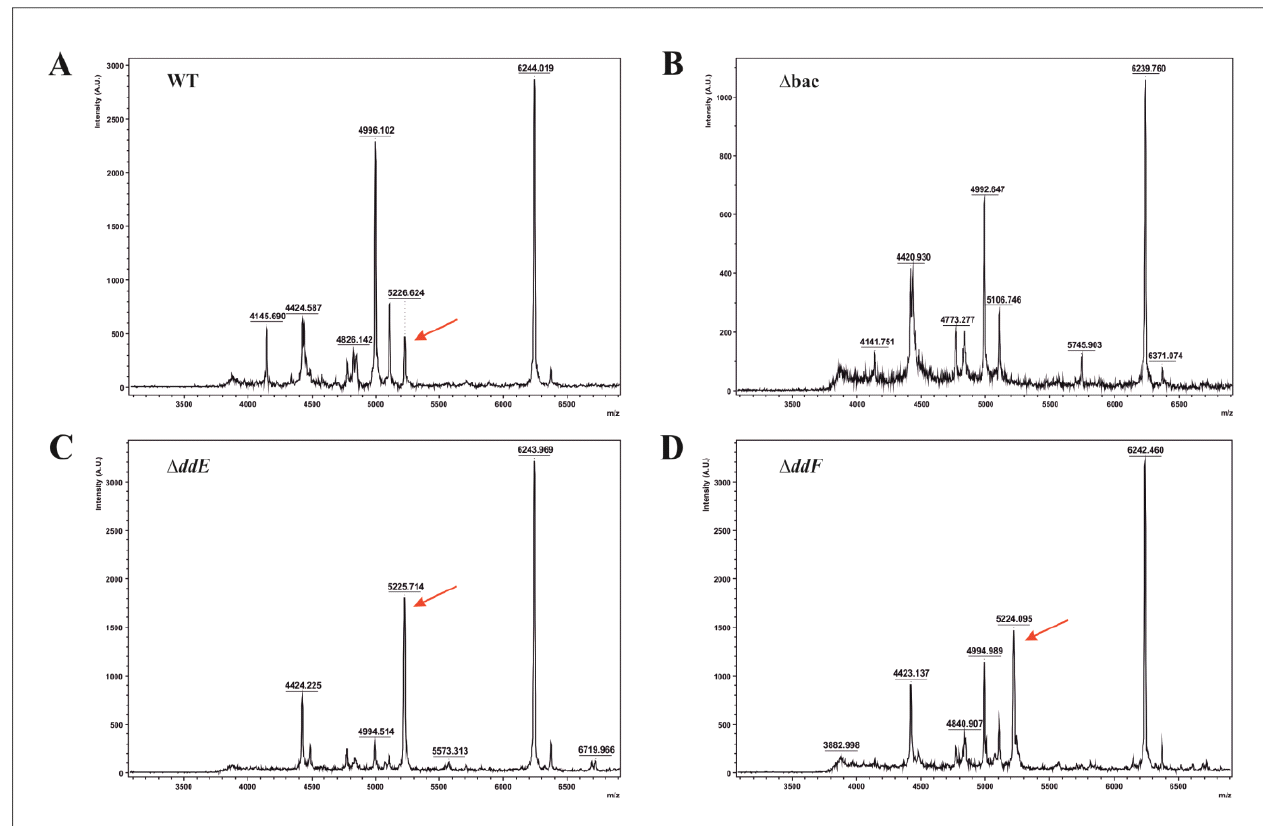
Figure 4. Matrix-assisted laser desorption ionization time-of-flight mass spectrometry (MALDI-TOF/MS) spectra obtained from intracellular fraction proteins of WT ( A ), Δbac ( B ), Δ ddE ( C ), and Δ ddF ( D ) strains. Red arrows mark the peaks corresponding to the EntDD14.